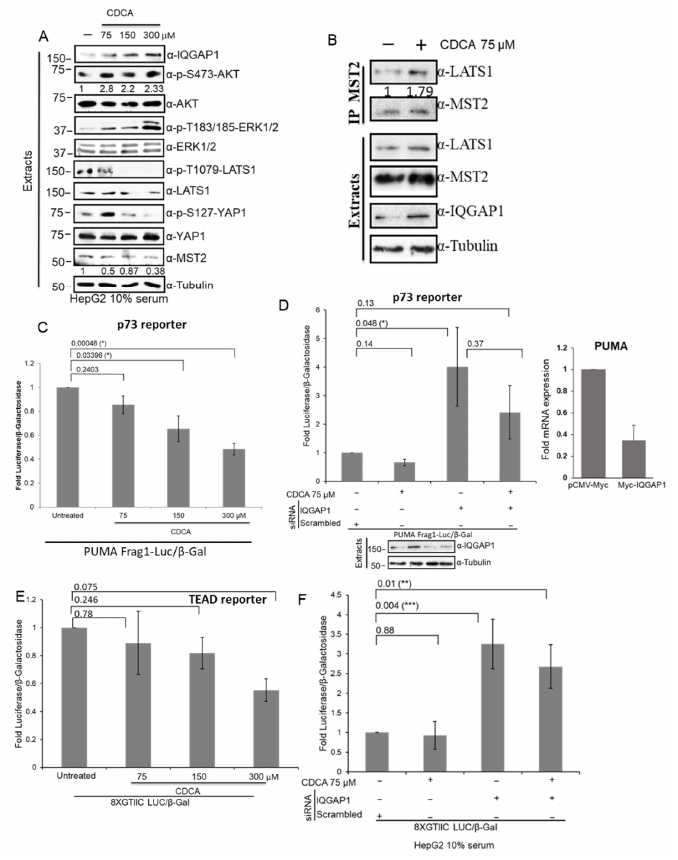
Figure 7. CDCA overload induces IQGAP1 expression and deactivates Hippo signalling. ( A ) HepG2 cells were treated with increasing concentrations of CDCA (75, 150 or 300 µ M) for 8 h and the cells were lysed. Cell extracts were analysed by western blotting with indicated antibodies. Blots were quantified using ImageJ and the numbers show relative fold change of AKT phosphorylation normalised by total levels of AKT and level of expression of MST2 normalised by tubulin levels. ( B ) HepG2 cells were treated with 75 µ M CDCA for 8 h. MST2 was immunoprecipitated from cell extracts using specific antibody. Immunoprecipitated proteins and cell extracts were blotted with the indicated antibodies. IP blots were quantified using ImageJ and the numbers show relative fold change of LATS1 normalised by MST2 blot. ( C ) HepG2 cells were co-transfected with PUMA promotor luciferase reporter (PUMA Frag1-Luc, p73 reporter) and β -galactosidase construct. Forty-eight hours after transfection, the cells were treated for 8 h with the indicated concentrations of CDCA. p73 transcriptional activity was measured by luminescence and β -galactosidase enzymatic activity was measured by absorbance. ( D ) Left panel. HepG2 cells were co-transfected with PUMA and β -galactosidase reporters and 50 ng/mL IQGAP1 or non- targeting siRNA pool where indicated. Forty-eight hours after transfection, the cell were treated for 8 h with 75 µ M CDCA. Transcriptional activity was measured as in ( C ). Lower panel shows protein expression of the indicated proteins determined by western blot in a representative experiment. Right panel. HepG2 cell were transfected with 0.5 µ g Myc-IQGAP1 or pCMV-Myc plasmids and PUMA mRNA expression was measured by rtPCR. The graph shows PUMA mRNA levels normalised by GAPDH mRNA expression. ( E ) HepG2 cells were transfected with 8XGTIIC LUC construct (TEAD reporter) β -galactosidase plasmid. Forty-eight hours after transfection, the cells were treated for 8 h with increasing concentrations of CDCA. TEAD transcriptional activity was measured and β -galactosidase enzymatic activity were measured as in C. ( F ) HepG2 cells were co-transfected with 8XGTIIC LUC construct (TEAD reporter) β -galactosidase plasmid and 50 ng/mL IQGAP1 or non-targeting siRNA pool, where indicated. Forty-eight hours after transfection, the cells were treated for 8 h with 75 µ M CDCA. After lysis, TEAD transcriptional activity was determined as in ( C ). p -values were obtained by Student’s t -test, n = 3, error bars indicate mean SEM. * = p < 0.05, ** = p < 0.01, *** = p <